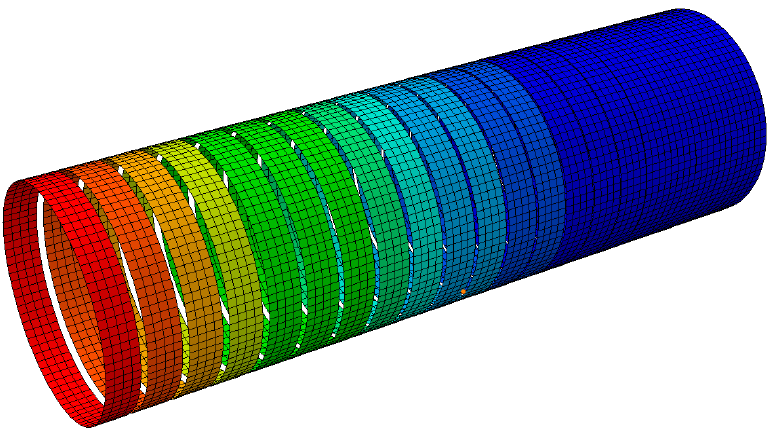
Figure 9. Cloud diagram of the longitudinal displacement of the segment lining without any rein- forcement measures after thrust unloading.